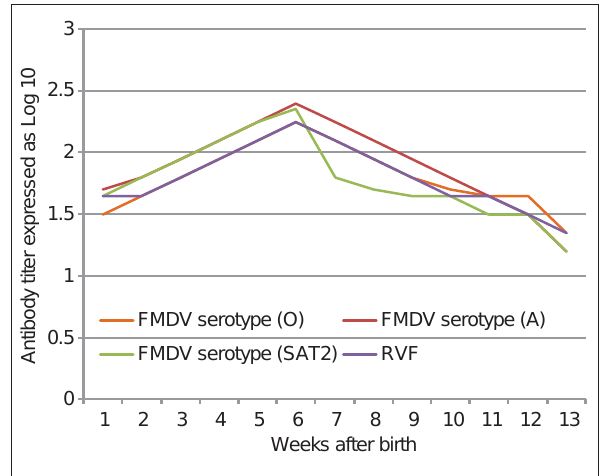
Figure-4: Mean antibody titers in newborn lambs from vaccinated ewes with combined Foot and Mouth disease/Rift Valley Fever vaccine estimated by serum neutralization test. Table-1: FMD lesions and protection percentage in sheep vaccinated with combined FMD/RVF and challenged against the three types of FMD virus. Animal